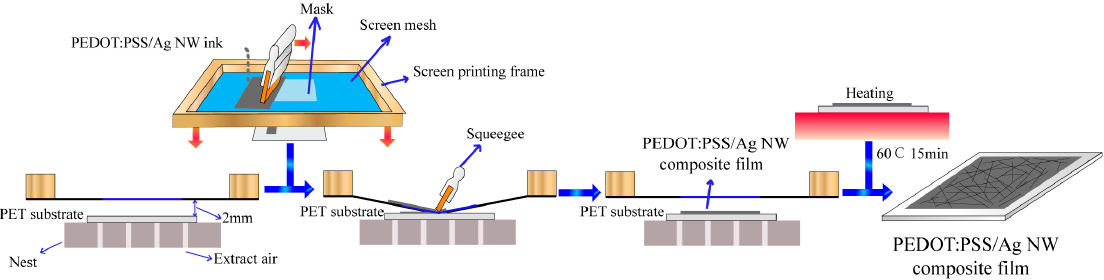
Figure 1. Schematic illustration of the screen-printed procedure of PEDOT:PSS/Ag NW composite films. PEDOT:PSS: poly(3,4-ethylenedioxythiophene) poly(styrenesulfonate); NW: nanowire.